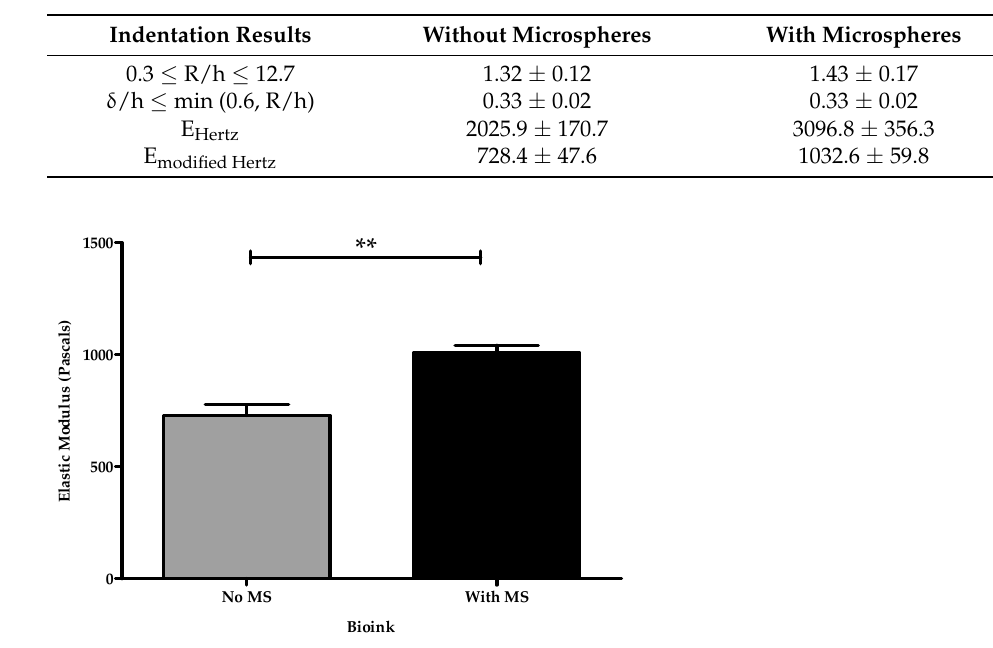
Table 1. Indentation parameters and elastic moduli values obtained for bioink with and without microspheres.